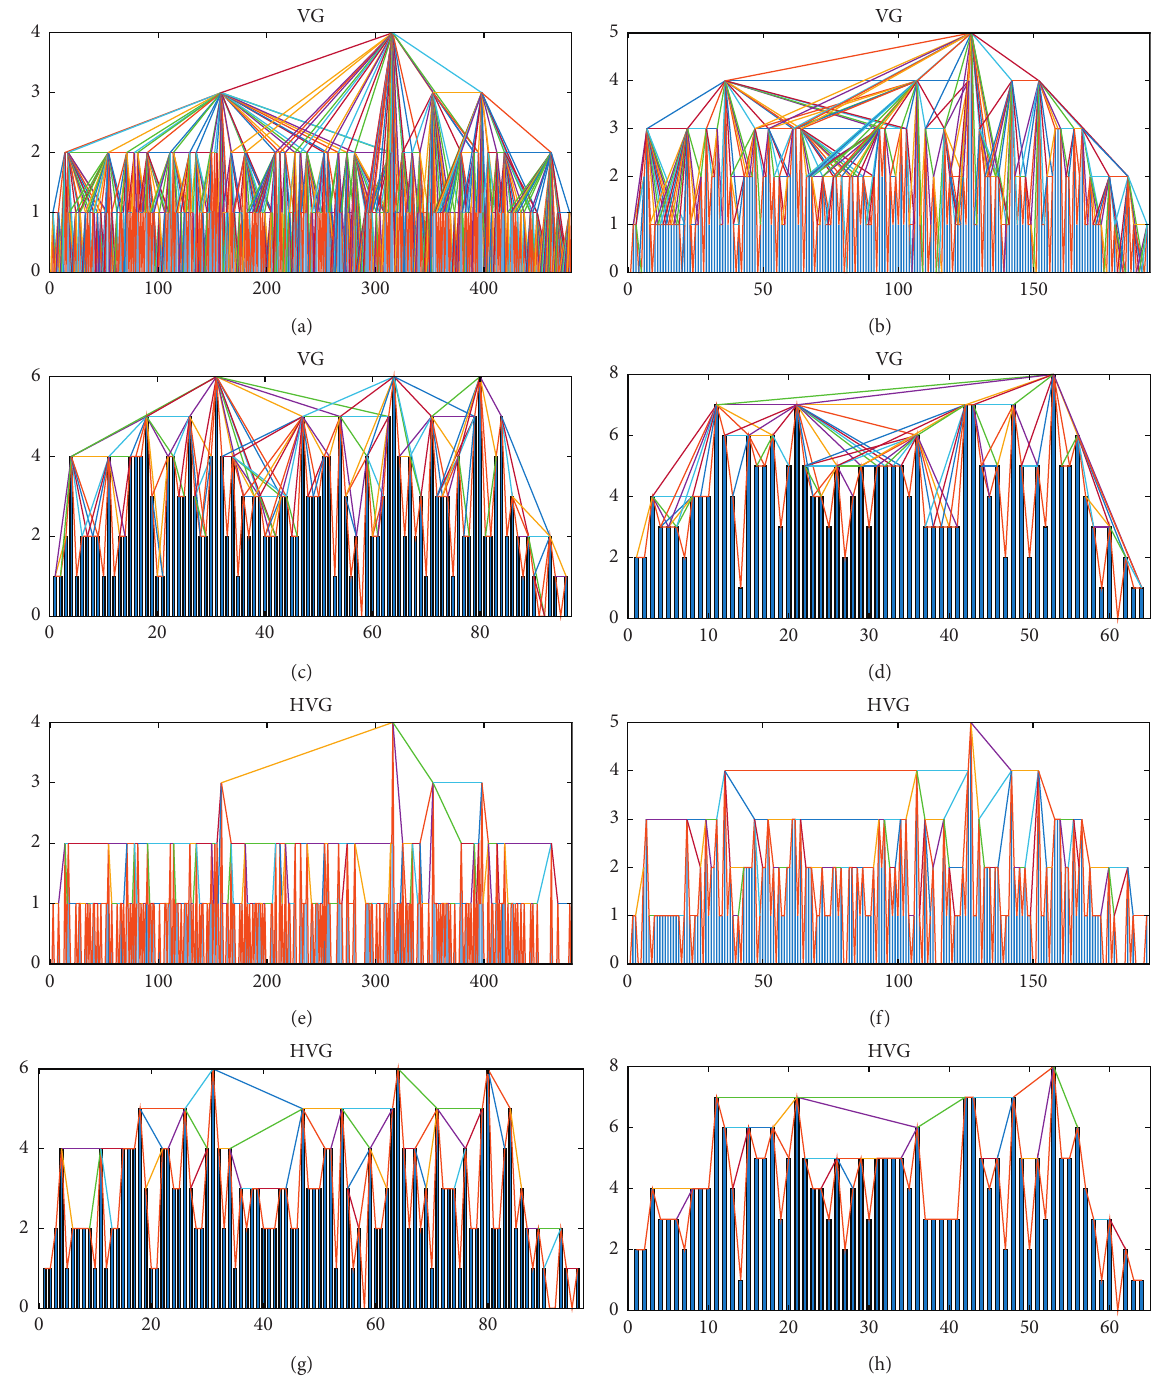
Figure 9: Visual graph and horizontal visual graph of the sample. (a) Δ t � 2min. (b) Δ t � 5min. (c) Δ t � 10min. (d) Δ t � 15min. (e) Δ t � 2min. (f) Δ t � 5min. (g) Δ t � 10 min. (h) Δ t �